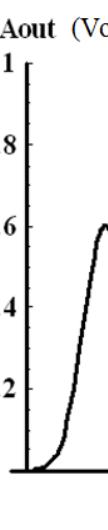
Figure 18. Multiple reflections arriving at the detector.